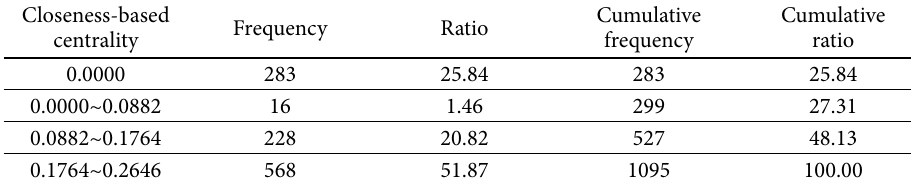
Table 5. Distribution of closeness-based centrality in the NBI network Closeness-based centrality